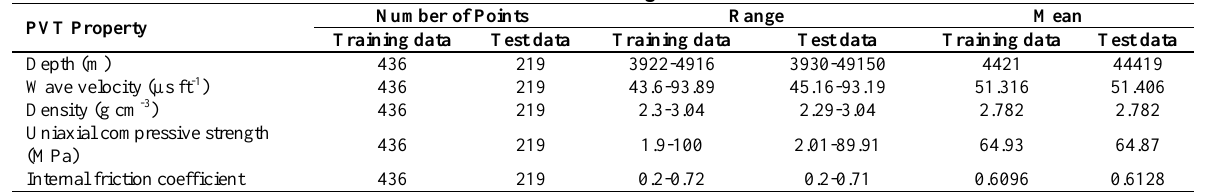
Table 1. Data ranges used.